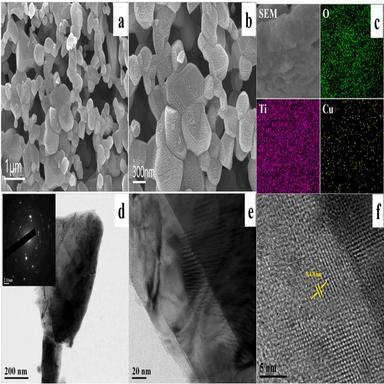
SEM image (a), high-resolution SEM image (b) of the LTO-0.1Cu composite. (c) EDS elemental maps of Ti, O, Cu. TEM image (d) and HRTEM (f) images of the LTO-0.1Cu composite. SEAD image (insert part) of the LTO-0.1Cu composite.